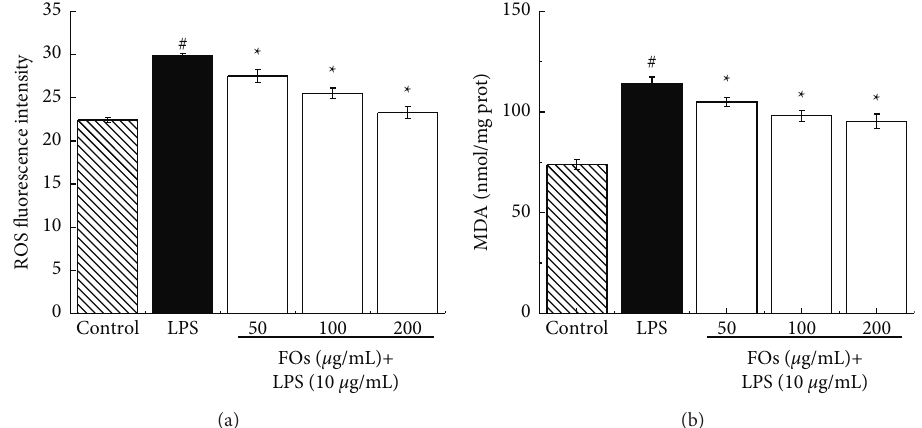
Figure 2: The effects of various concentrations of FOs-FWB on the level of ROS (a) and MDA (b) of LPS-stimulated IPEC-J2 cells. The data are expressed as the mean ± SE ( n � 3). # Indicates significant differences from control. ∗ Indicates significant differences from LPS. FOs- FWB: feruloyl oligosaccharides from fermented wheat bran.